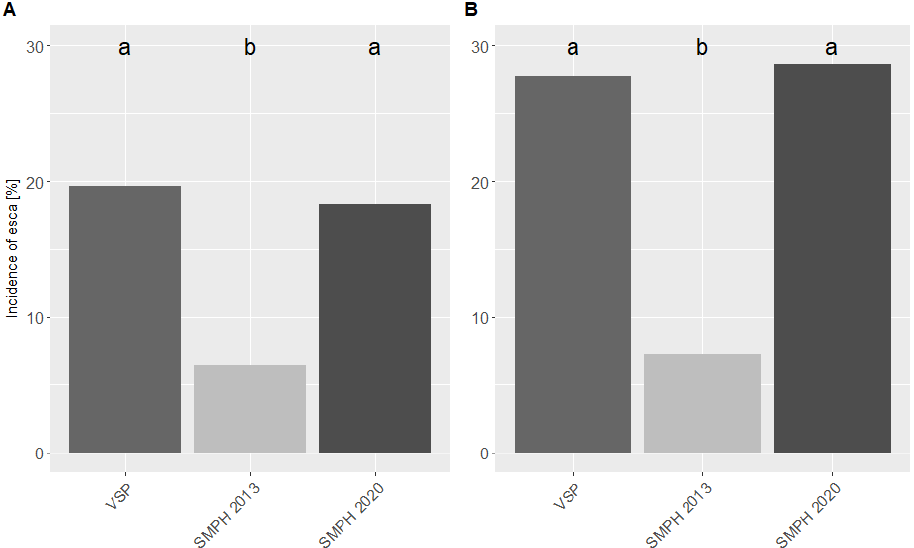
Figure 3. Total incidence of plants [%] showing external esca symptoms, i.e., GLSD (“tiger - stripes”) and apoplexy in the ‘Dornfelder’ vineyard monitored in ( A ) 2020 and ( B ) 2021 as a function of the pruning system (VSP and SMPH) and the time period of pruning conversion (‘201 3 ’ = after 10 years of intensive pruning; ‘202 0 ’ = after 17 years of intensive pruning). Different letters indicate significant differences in esca incidence according to Fisher´s exact test ( p <